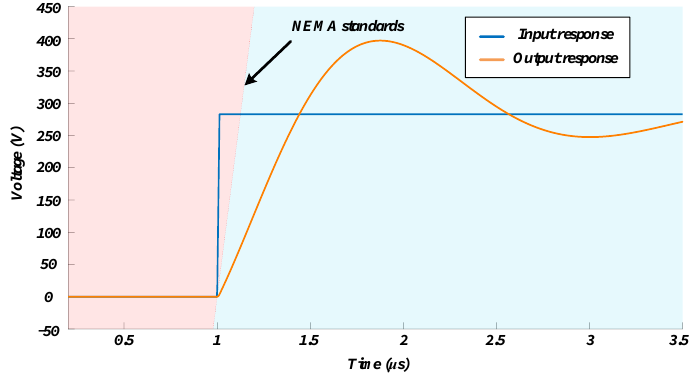
Figure 7. Time response graph considering real input signal. Table 2. Output filter parameters.